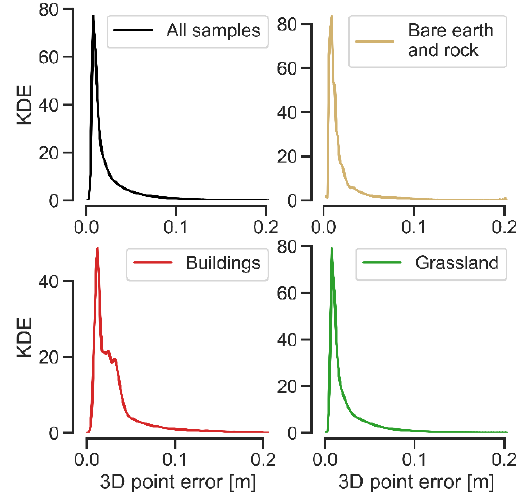
Figure 4. Distribution of 3D point error ( pe ) magnitudes (shown as kernel density estimate, KDE) in the 2019 point cloud for all samples and per